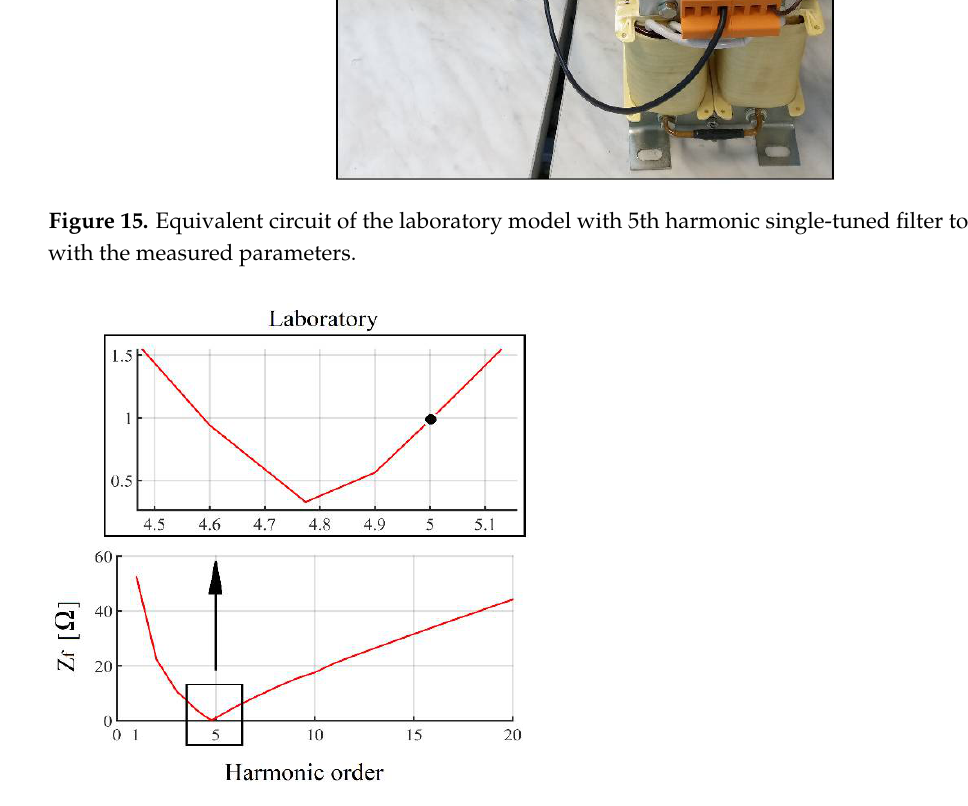
Figure 15. Single-tuned filter impedance versus frequency characteristic measured in the laboratory. Table 5. Summarized single-tuned filter parameters (one